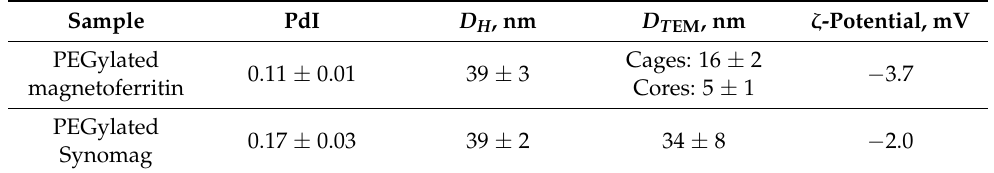
Table 1. Physical parameters for MFt and PEGylated synomag: polydispersity index (PdI) from dynamic light scattering (DLS), D TEM solid NP diameter from transmission electron microscopy (TEM), D H hydrodynamic diameter from DLS, and ζ -potential from electrophoretic light scattering (ELS). MFt was stabilized in HEPES-2 buffer, synomag in PBS (pH 7.4). Additional data can be found in Tables S1 and S2, Supplementary Information. Sample PdI D H , nm D T EM , nm ζ -Potential, mV PEGylated Cages: 16 ± 2 − 3.7 0.11 ± 0.01 39 ± 3 magnetoferritin Cores: 5 ± 1 PEGylated 0.17 ± 0.03 39 ± 2 34 ± 8 − Synomag